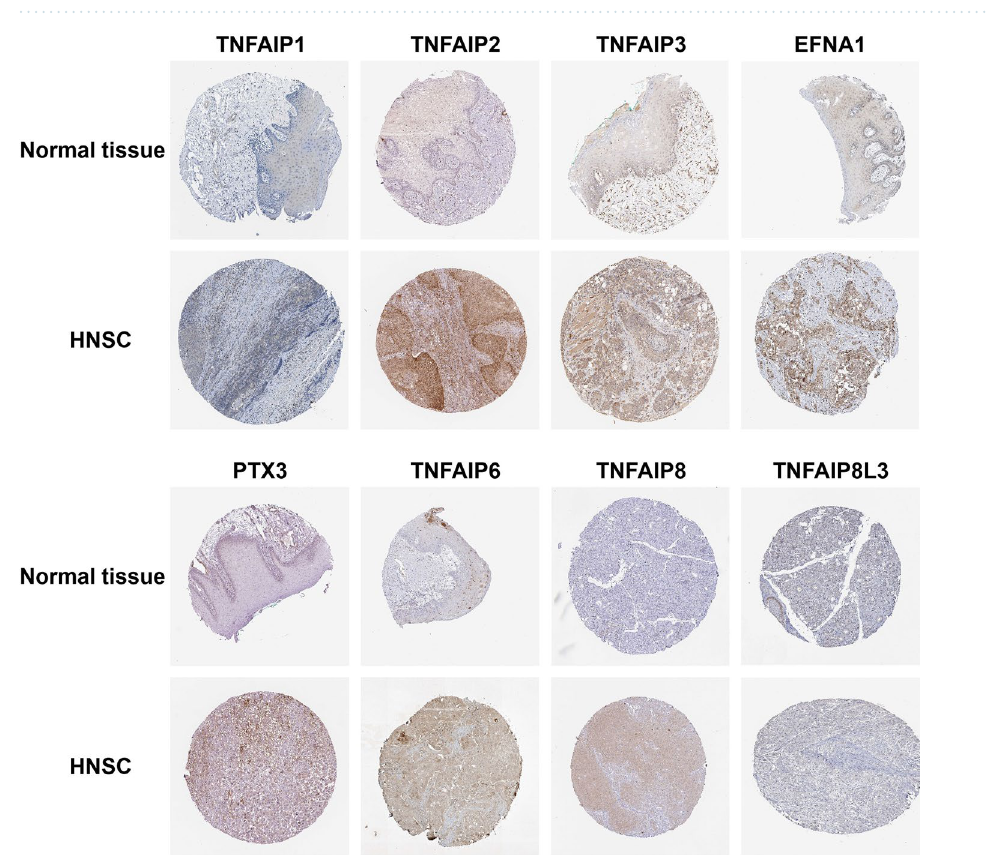
Figure 3. Representative immunohistochemistry images of TNFAIPs in HNSC and normal tissues. The protein levels of TNFAIP2, TNFAIP3, EFNA1, PTX3, TNFAIP6, and TNFAIP8 in HNSC tissues were higher than those in normal tissues (Human Protein Atlas) 52